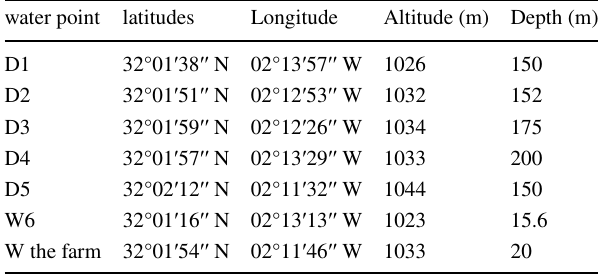
Table 2 Characterization of the sampling locations (Mebarki et